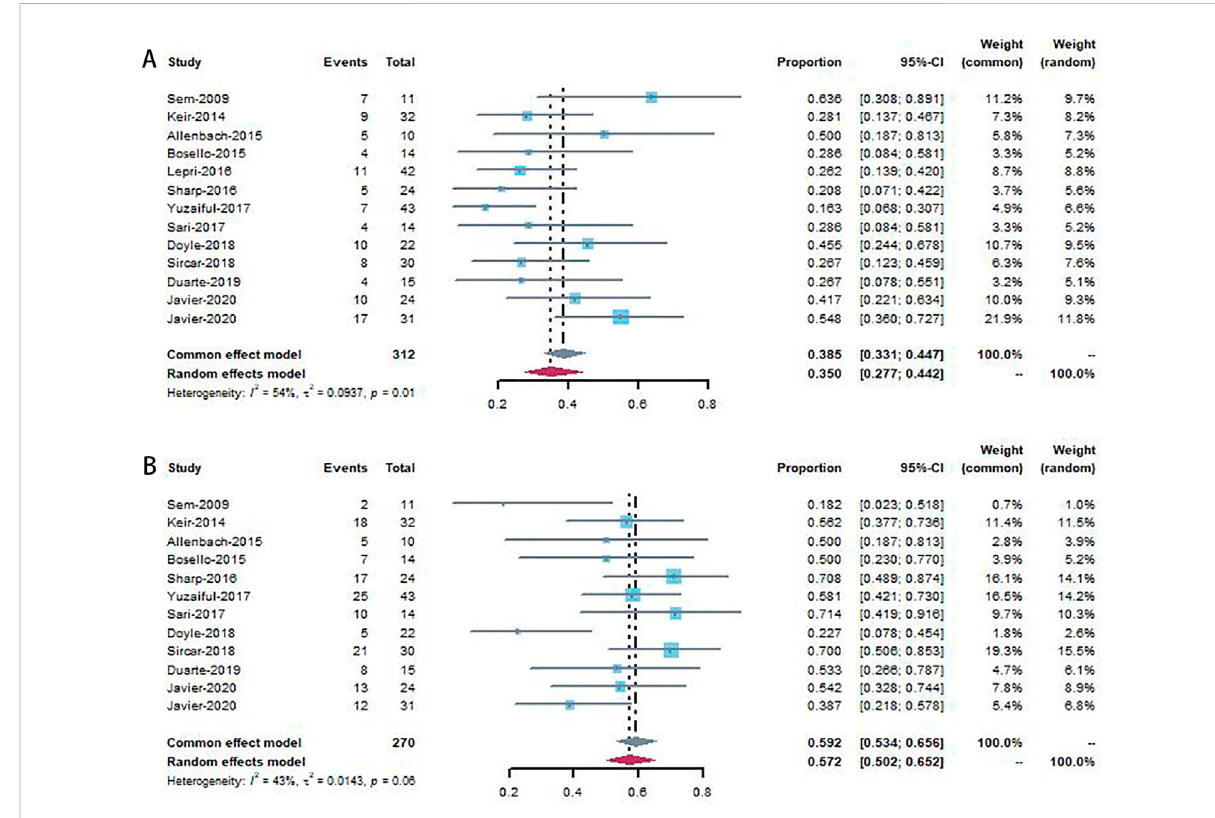
FIGURE 2 Forest plot showing improvement rate (A) and stable rate (B) to patients using